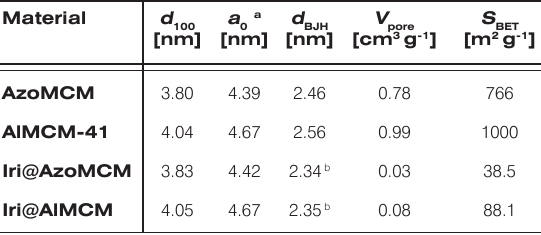
Table 1. Structural and textural properties of carriers and irinotecan- based hybrids. Material